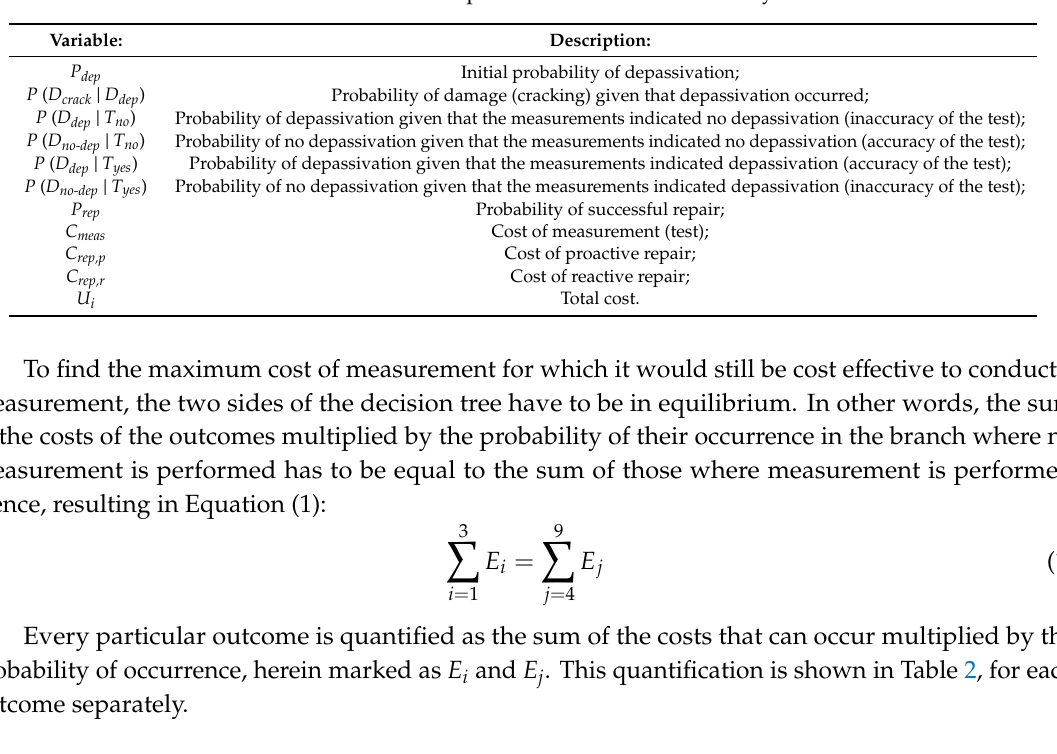
Table 2. Mathematical formulation of the outcomes in the decision tree formulated in Figure